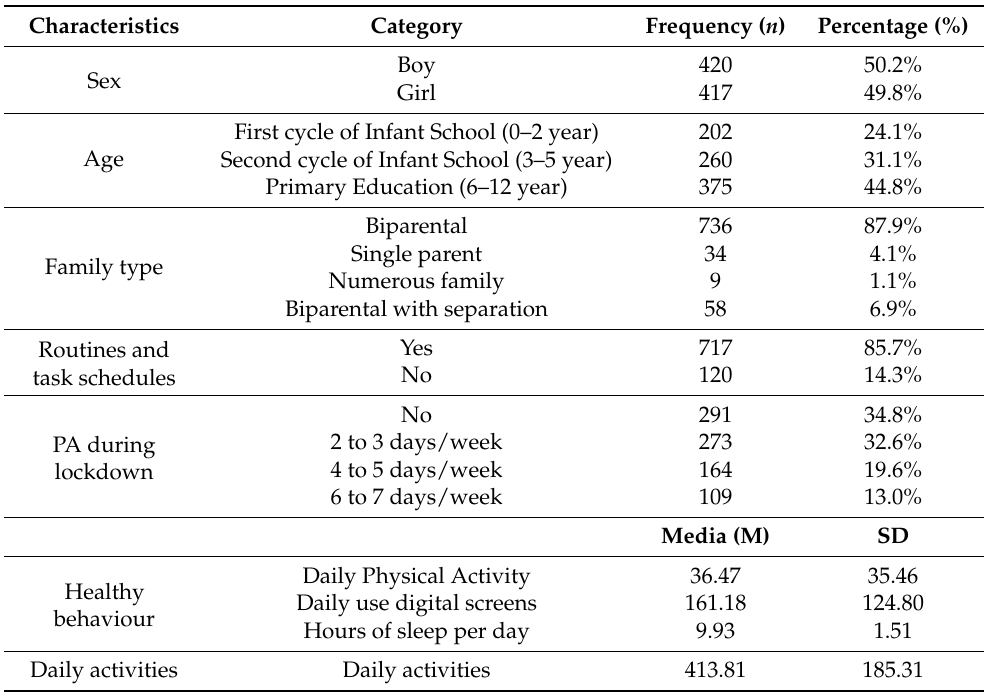
Table 2. Characteristics of the sample.